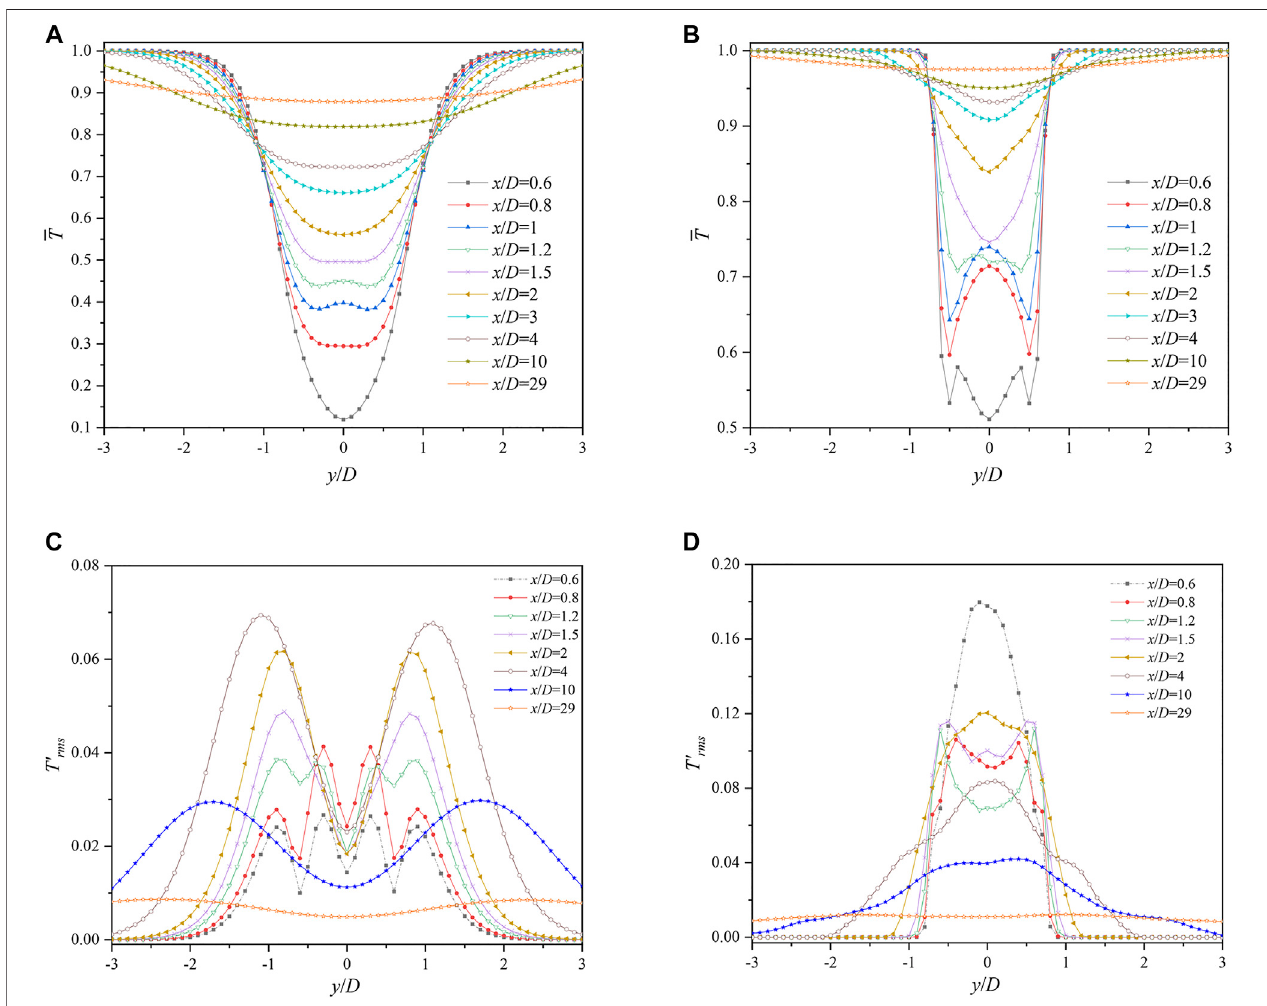
FIGURE8| Transversedistributionsof (cid:1) T and T ′ rms atdifferentdownstreamlocations. (A) (cid:1) T (LBE,Pr = 0.025); (B) (cid:1) T (air,Pr = 0.71). (C) T ′ rms (LBE,Pr = 0.025); (D) T ′ rms (air, Pr =